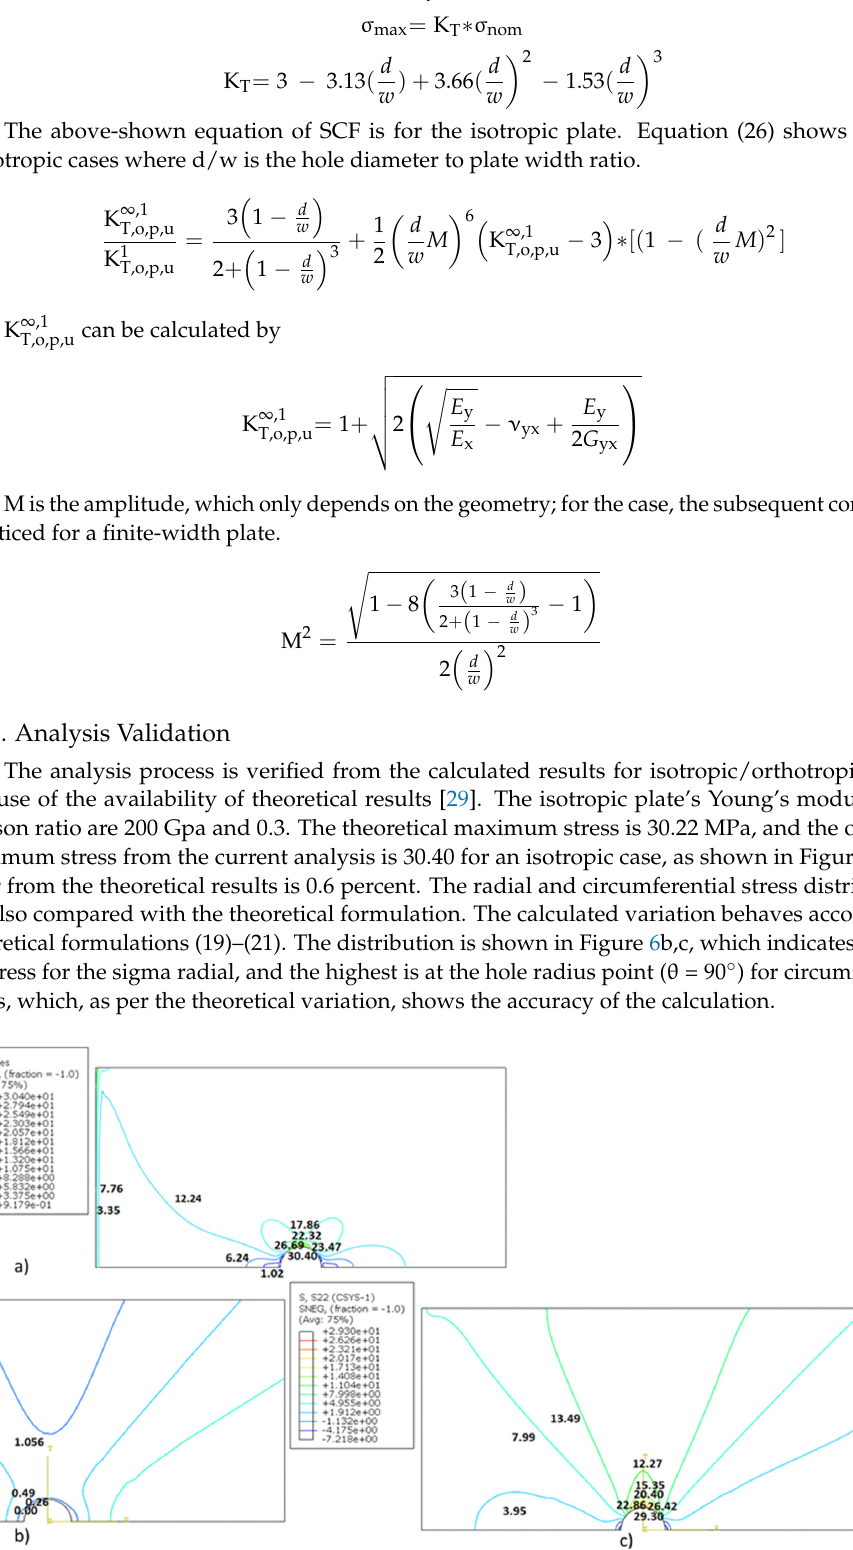
Figure 6. ( a ) Von Mises stress, ( b ) Radial stress, ( c ) Circumferential stress for the isotropic plate under uniform tension.